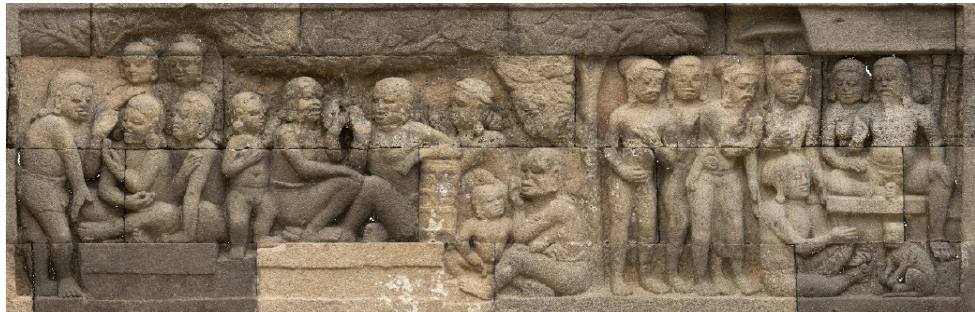
Figure 2. Borobudur Temple Relief, Karmawibhangga, panel No. 22, tells the story of a group of men carrying umbrellas who approached a holy man sitting in the shade of a wooden building, while people nearby were peacefully chatting. To tell these beautiful Buddhist stories, the reliefs are carved with different patterns that are raised only slightly from the background. The reliefs can be divided into several semantic labels: characters, plants, animals, ships, buildings, and so on.